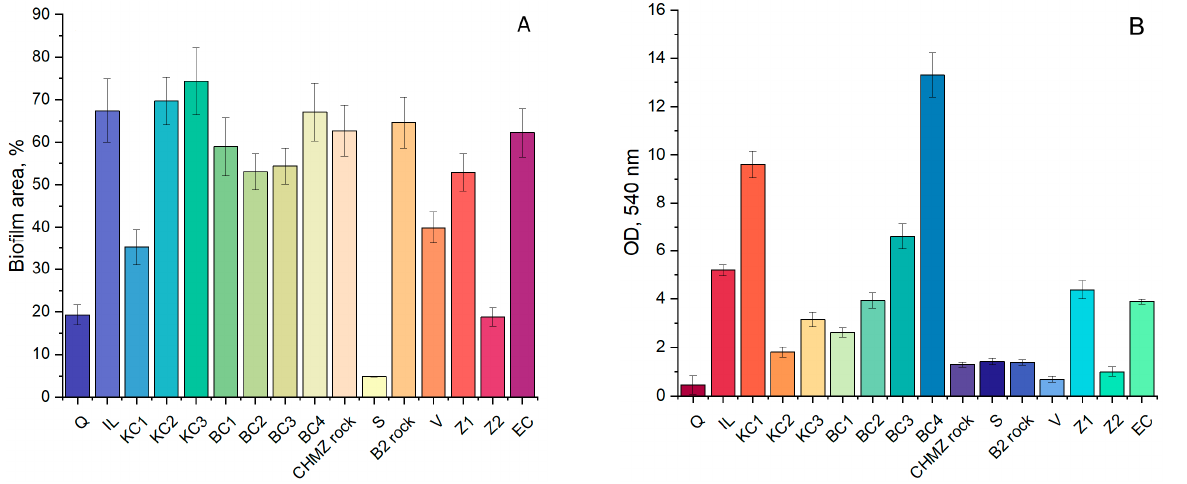
Figure 4. The area of biofouling of carriers by the indigenous microbial community, % according to confocal microscopy studies ( A ) and MTT assay ( B ).